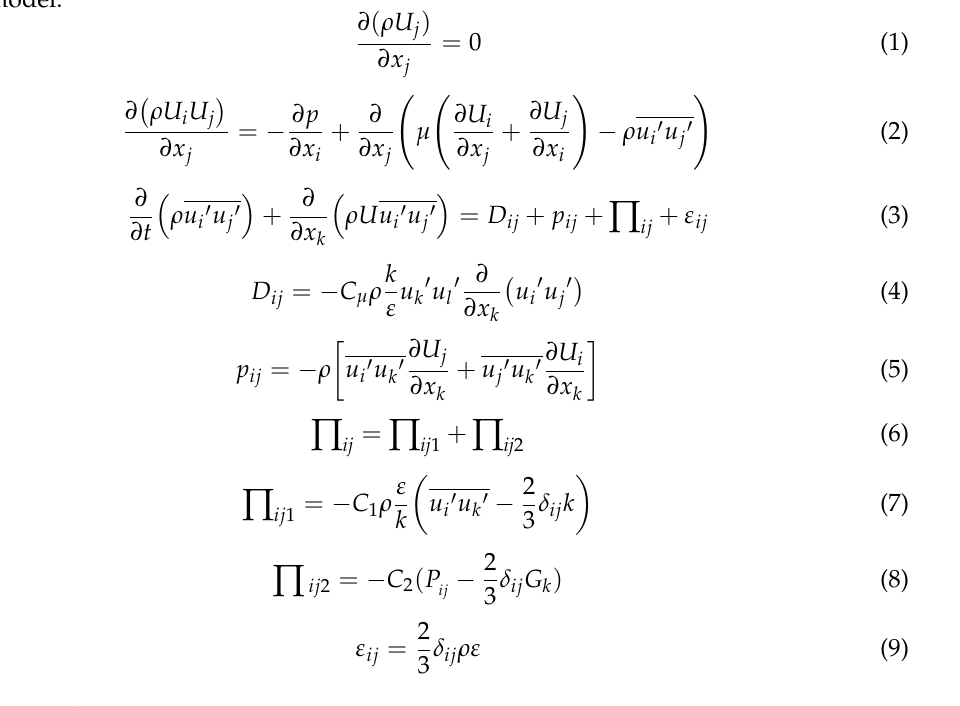
Table 2. Boundary parameters of the inlet. Parameters Value